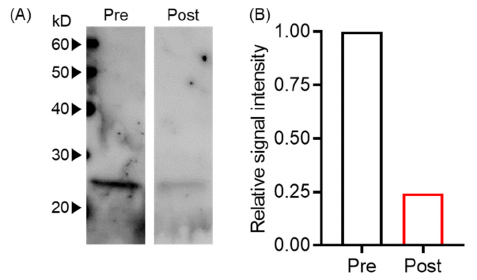
Figure 2. Plasma exchange-reduced EVs. ( A ) T-EV levels pre- and post-plasma exchange were analyzed by Western blot with anti-human CD9 antibody. ( B ) The signal intensity of Western blot bands in Figure 2A was normalized with pre-plasma exchange.